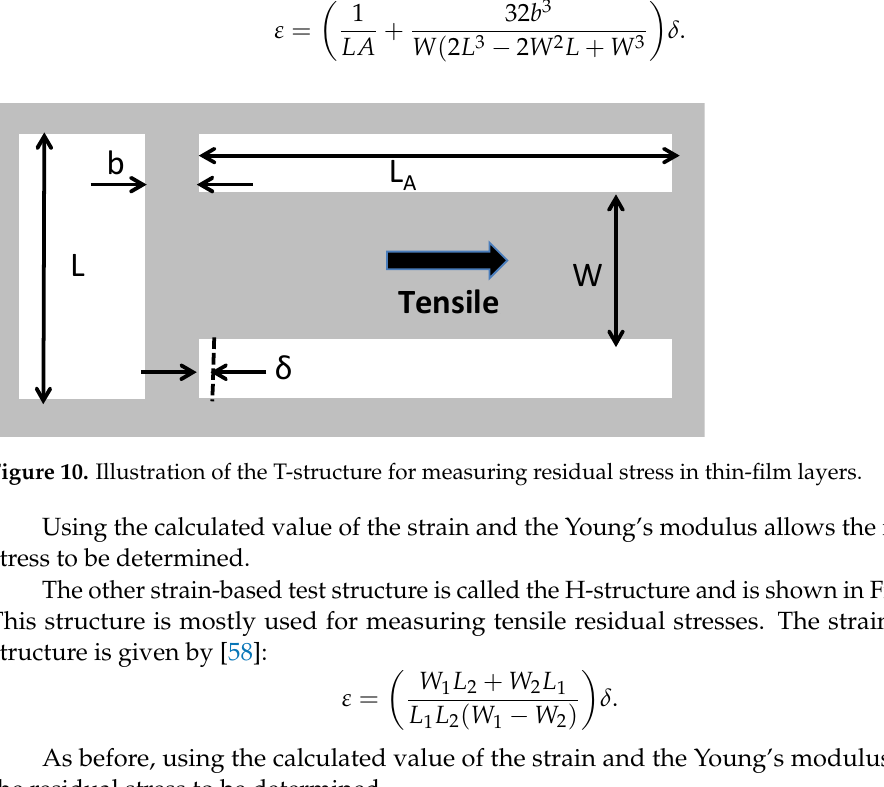
Figure 11. Illustration of the H-structure for measuring residual stress in thin-film layers. 5.2.4. Electrostatic Pull-In Test Structures The electrostatic pull-in test structures employ a free-standing cantilever, beam or other type of mechanically compliant element fabricated over a ground plane on the substrate surface with a free-space gap between the mechanically compliant element and the ground plane over which a voltage potential is applied. If the voltage is sufficiently large, the mechanically compliant element will pull-in towards the ground plane. Since the pull-in voltage is dependent on the dimensions, material type of the mechanical ele- ment, as well as residual stress in the material layer the mechanical element is made from, the residual stress can be determined. The pull-in voltage of a beam type of me- chanical element fixed on both ends as a function of the dimensions and the residual